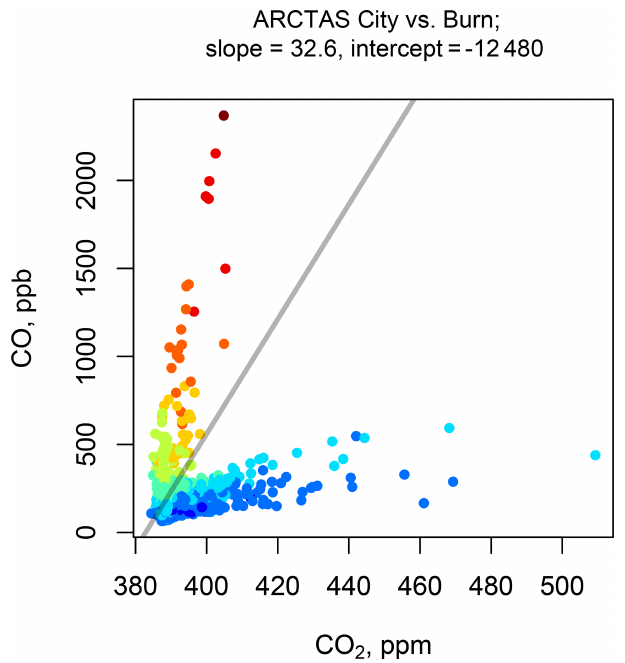
Figure 2. Urban and forest fire plumes are separable by the ratio of CO to CO2. Colors indicate a relative measure of CH 3 CN above the background, from blue (lowest, ∼ 0.1ppb) to red (highest, ∼ 6ppb) values. The straight gray line indicates our selected discrimination between nonurban and